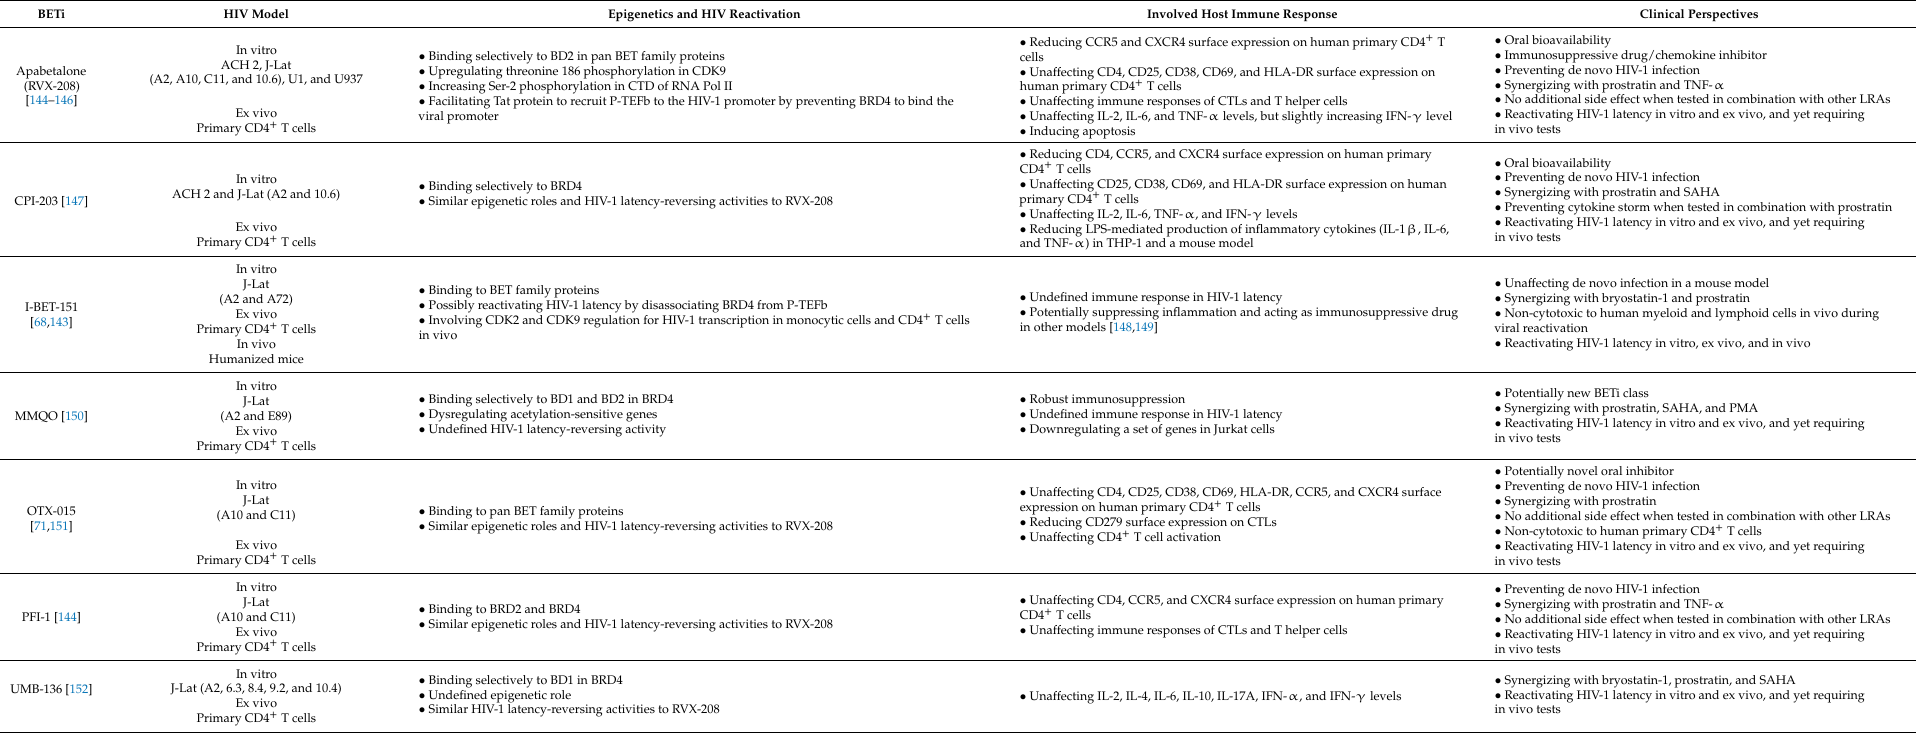
Table 1. Currently interesting BETis and their potentials in AIDS